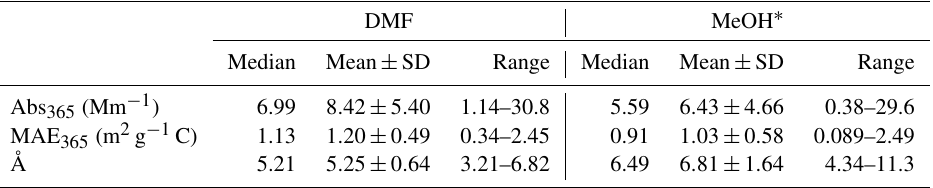
Table 3. Comparisons of light-absorbing properties of ambient PM 2 . 5 extracts in DMF and MeOH derived from duplicate Q f –Q b data ( N = 109).